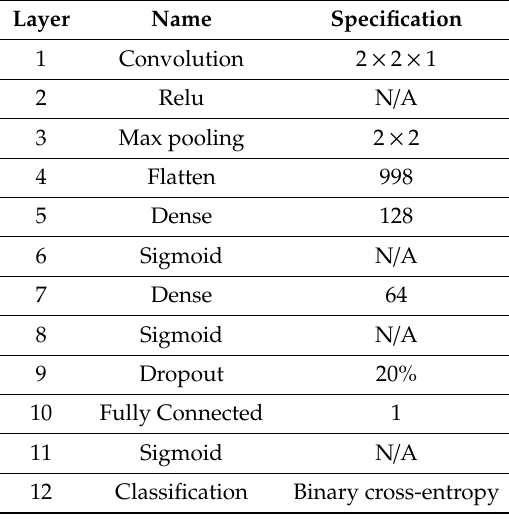
Table 6. Structure of the 1D-CNN model.